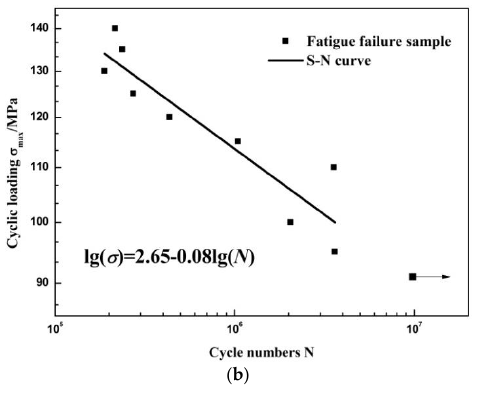
Figure 1. The strength curves of AZ31B magnesium alloy: ( a ) The tensile stress–strain curve; ( b ) S – N curve.